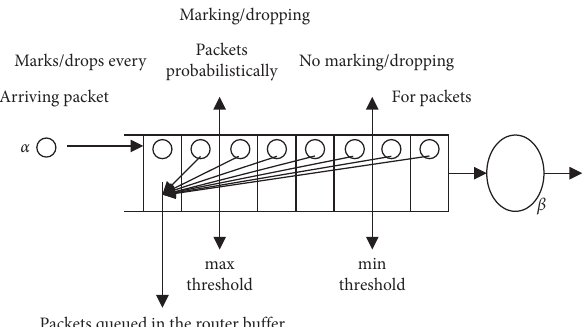
Figure 4: The single router buffer for RED, NLRED, or the pro- posed RED_E.